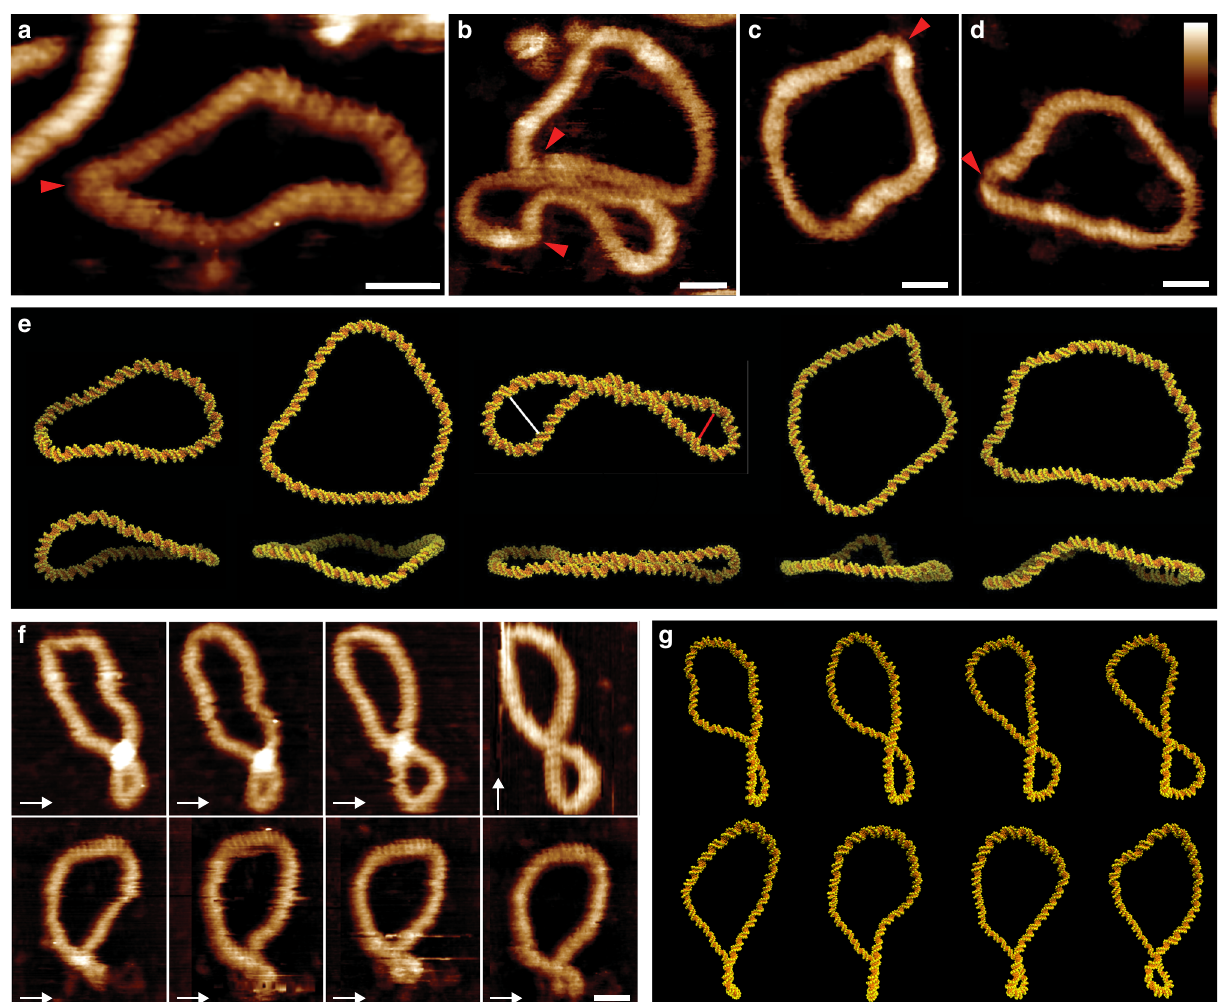
Fig. 1 Structural and dynamic diversity in supercoiled DNA minicircles. a – d High-resolution AFM images of natively supercoiled ( σ = 0.03 – 0.06) DNA minicircles of 251 bp ( a ) and 339 bp ( b – d ) showing their helical structure and disruptions of canonical B-form DNA (marked by red arrowheads), where the angle of the helix changes rapidly, or where the DNA appears thinner or disrupted. Aspect ratios for each molecule: 048 ( a ), 0.44 ( b bottom), 0.87 ( b top), 0.78 ( c ) and 0.65 ( d ). e MD snapshots of minicircle conformations for 251 ( fi rst image) and 339 bp corresponding to the minicircles in the AFM images selected by visual inspection from explicitly solvated simulations ( fi rst, second and third images at Δ Lk − 1, 0 and − 2, respectively) and from implicitly solvated simulations (fourth and fi fth image) at Δ Lk = 0. Top and side views (top and bottom row, respectively) show the degree of planarity of the depicted structures, where top refers to the top view of adsorbed DNA minicircles, and side the perpendicular plane. White and red lines indicate plectonemic loops of 9 and 6.5 nm width, respectively (see ‘ Methods ’ ). Aspect ratios are 0.45 ± 0.04, 0.30 ± 0.03, 0.86 ± 0.01, 0.81 ± 0.01 and 0.69 ± 0.01. f Time-lapse AFM measurements of a natively supercoiled 339 bp DNA minicircle, recorded at 3 min/frame. Fast scan direction is shown by white arrows. g Chronological snapshots from simulations of 500 ps duration for a 339 bp minicircle with Δ Lk = − 1 (see Supplementary Videos 6 and 7). Scale bars (inset): 10 nm and height scale (inset, d ): 2.5 nm for all AFM